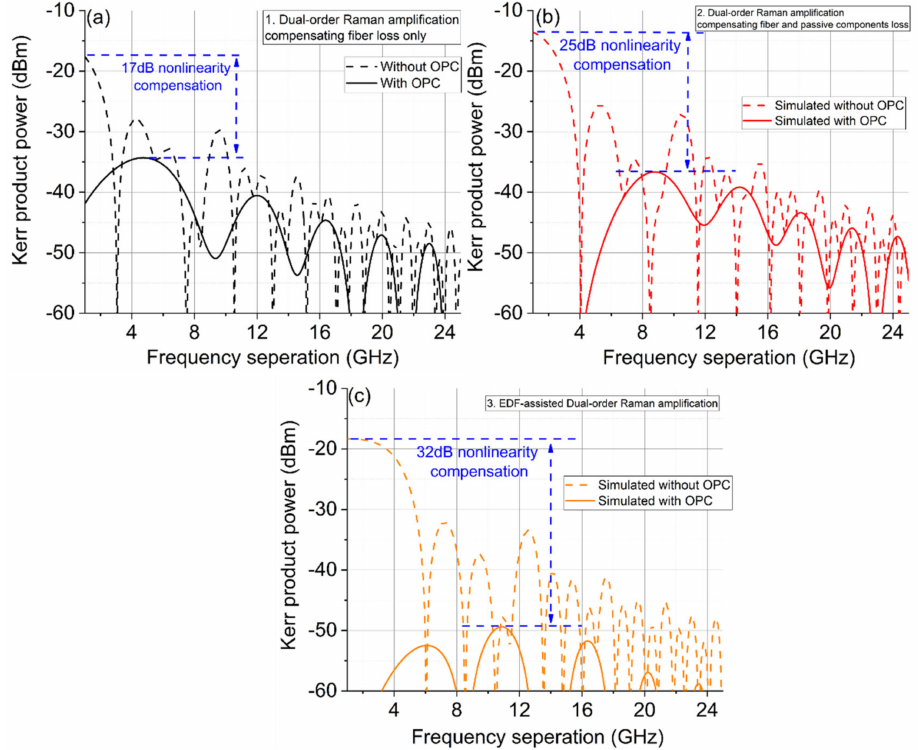
Figure 14. Theoretically predicated nonlinear product frequency separation without/with a mid- link OPC using different DRA schemes over 2 × 50 km spans. Dotted lines—no OPC, solid-with OPC. ( a ) No account of loss, ( b ) accounting for loss with excess Raman gain, ( c ) accounting for loss with